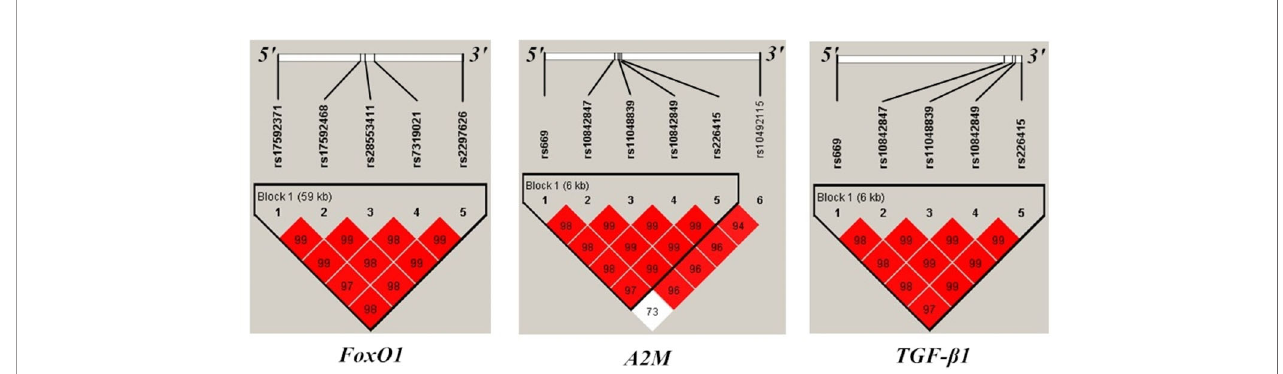
FIGURE 1 | Position and linkage disequilibrium (LD) map of genotyped polymorphisms in FoxO1, A2M, and TGF- b 1gene. Pairwise LD statistics in examined genes were calculated with Haploview. Squares are bright red if the |D ’ | value is high, that is, LD is strong.